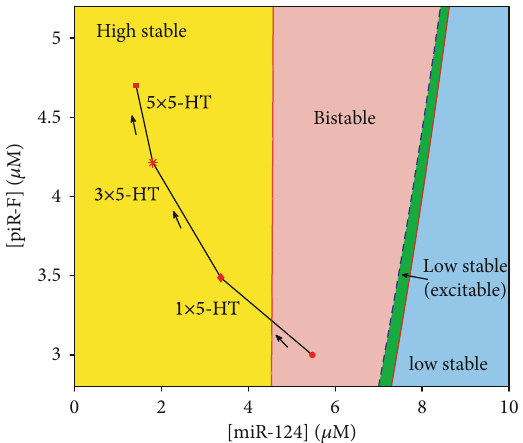
Figure 8: Bifurcation diagram in the ð½ miR ‐ 124 (cid:2) , ½ piR ‐ F (cid:2)Þ parameter plane. The red solid line and blue dashed line depict the saddle-node bifurcation points (SN) and subcritical Hopf bifurcation points (subH),